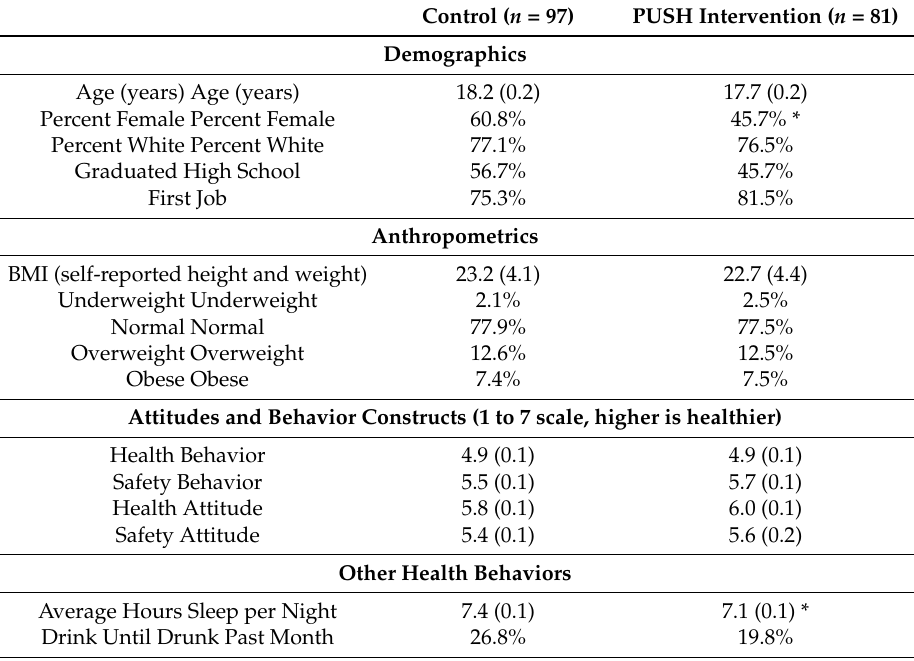
Table 3. Baseline descriptive information (percentages and means (standard